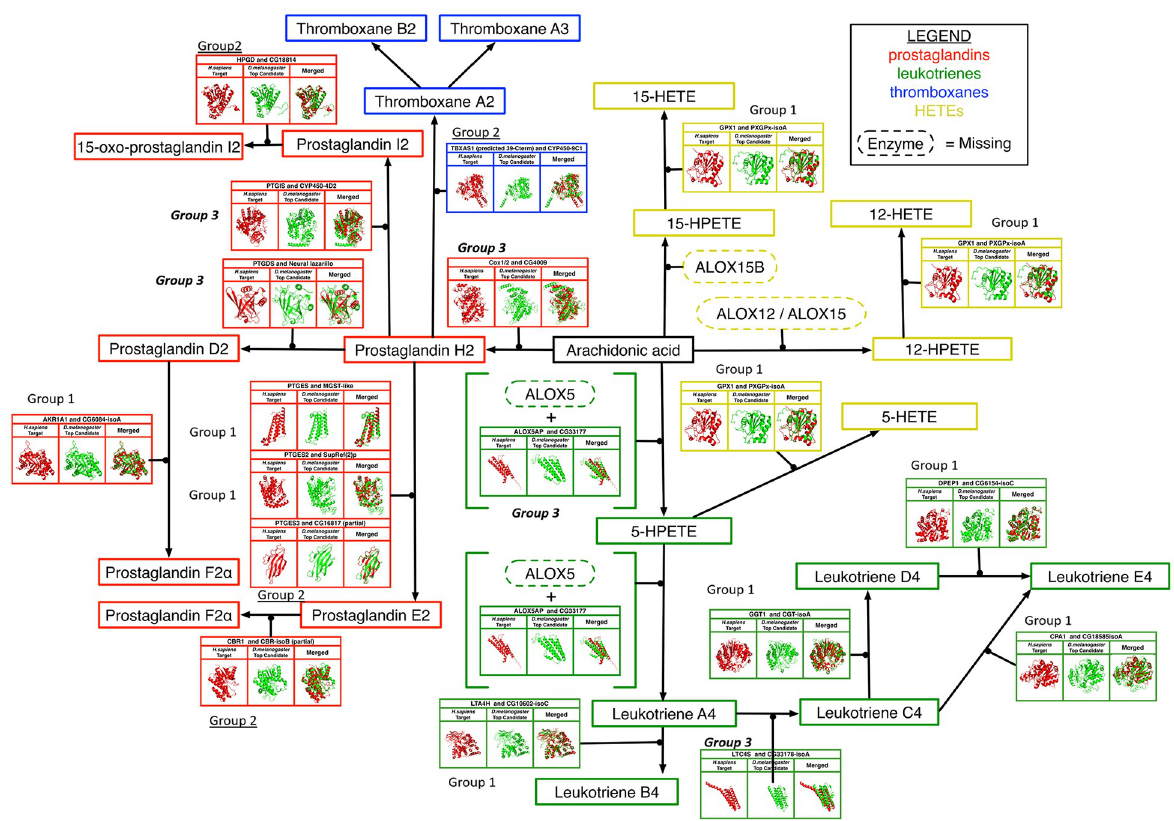
Fig 3. A theoretical eicosanoid synthesis pathway in D . melanogaster . A graphical overview of fly candidates in the putative pathway shown alongside the human enzymes as well as superposed with it. Boxed names represent the intermediates or end products (Red: Prostaglandins; Blue: Thromboxanes; Green: Leukotrienes; Yellow: HETEs). Enzymes for which orthologs could not be identified are represented by dashed ovals. The three candidate groups are marked next to the enzymes in a similar manner as Table 1: high-confidence (regular font; Group 1), mid-range (underlined; Group 2), and distant ( italicized and bold font; Group 3